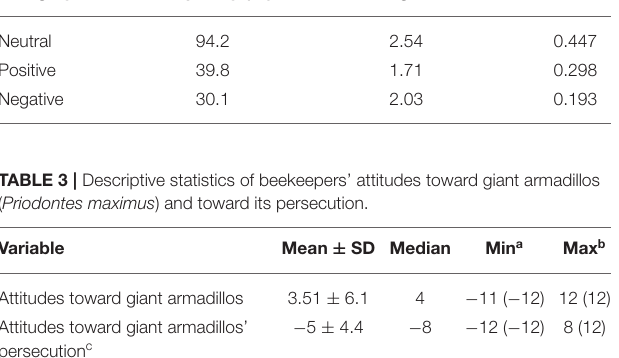
Frontiers in Conservation Science |